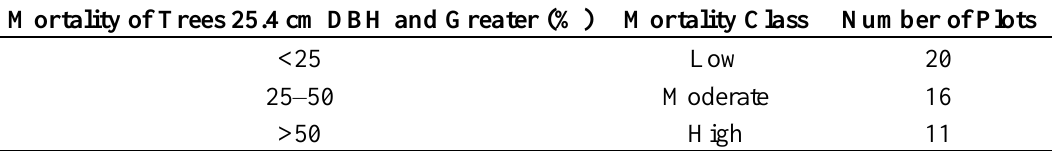
Table 1. Plot-level mortality